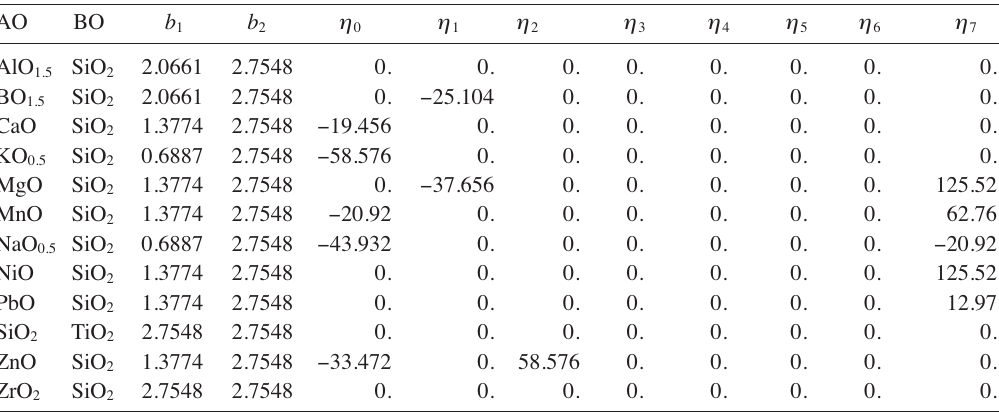
Table IV. Non-configurational excess entropy parameters of modified- quasi -chemical model for binary silicate melts (after Pelton et al. , 1995). AO BO